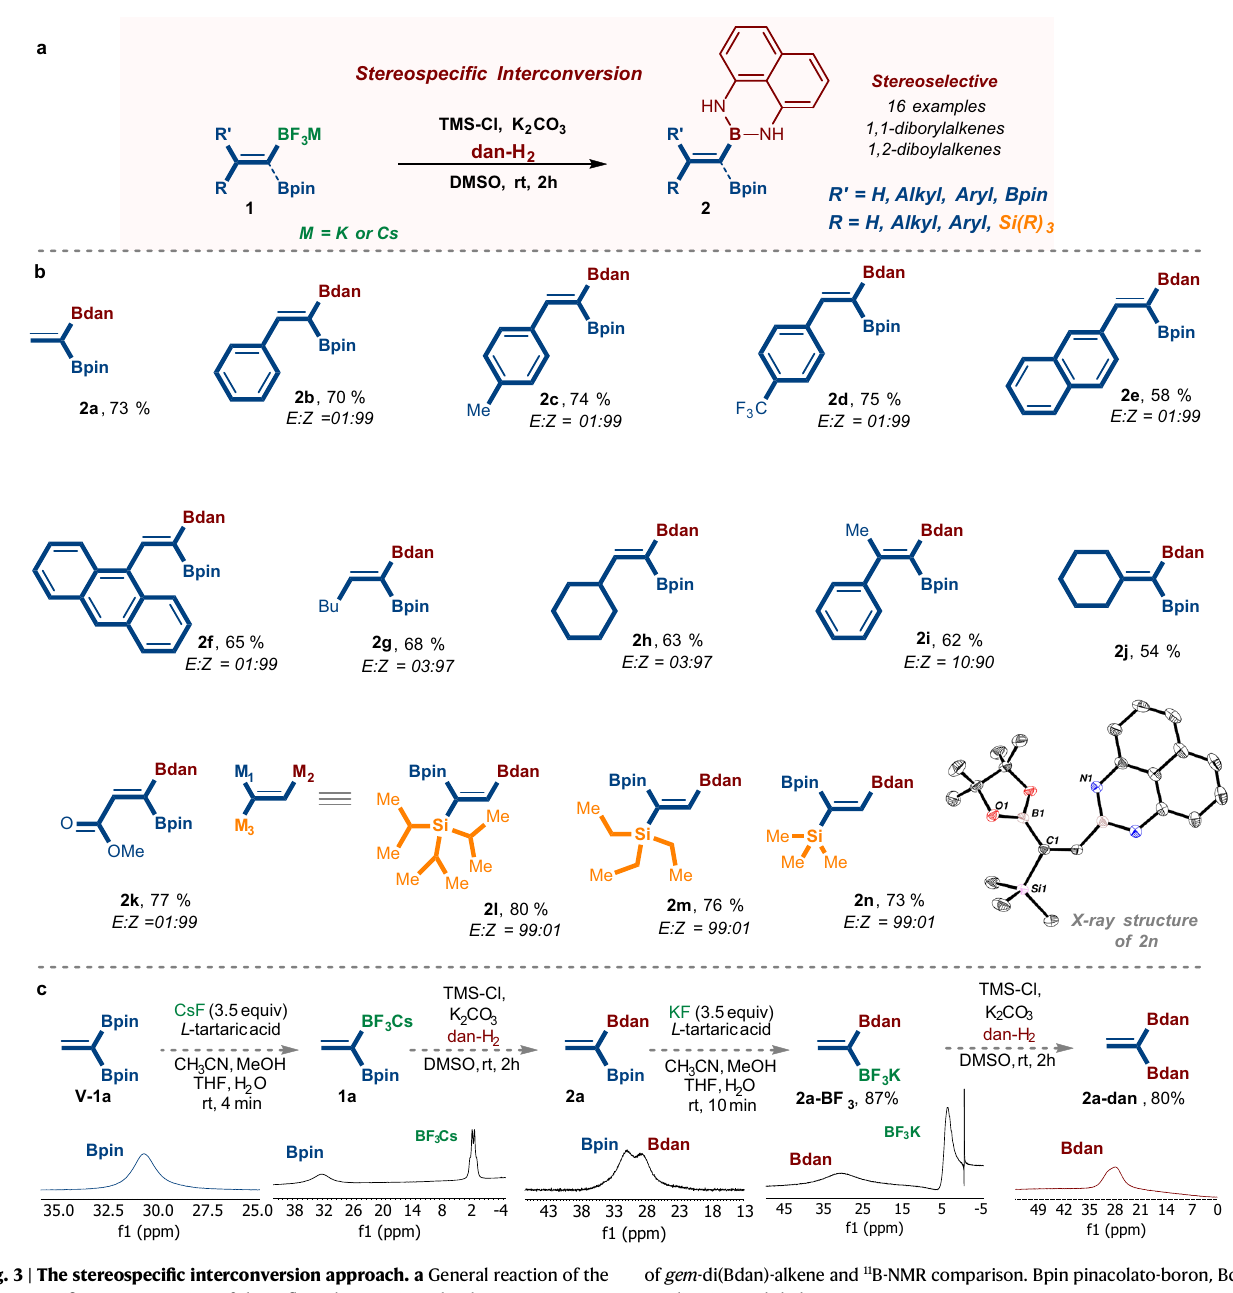
of gem -di(Bdan)-alkene and 11 B-NMR comparison. Bpin pinacolato-boron, Bdan B-